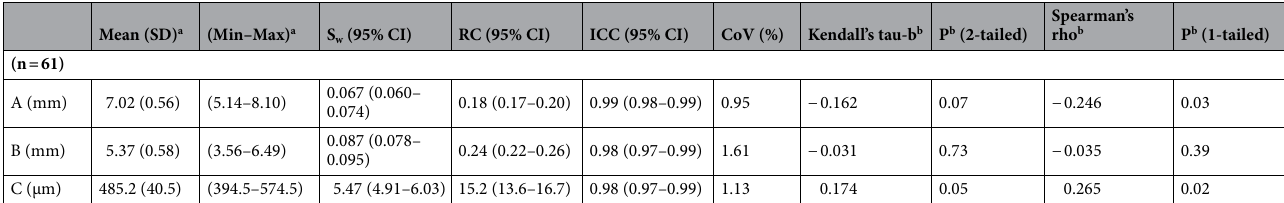
Table 1. Descriptive statistics and repeatability of Pentacam measurements made on a single day in subjects with keratoconus. A = Anterior curvature of the 3 mm zone over the thinnest point (mm). B = Posterior curvature of the 3 mm zone under the thinnest point (mm). C = Thickness of the thinnest point on the cornea (μm). a Subject mean. b Subject SD versus subject